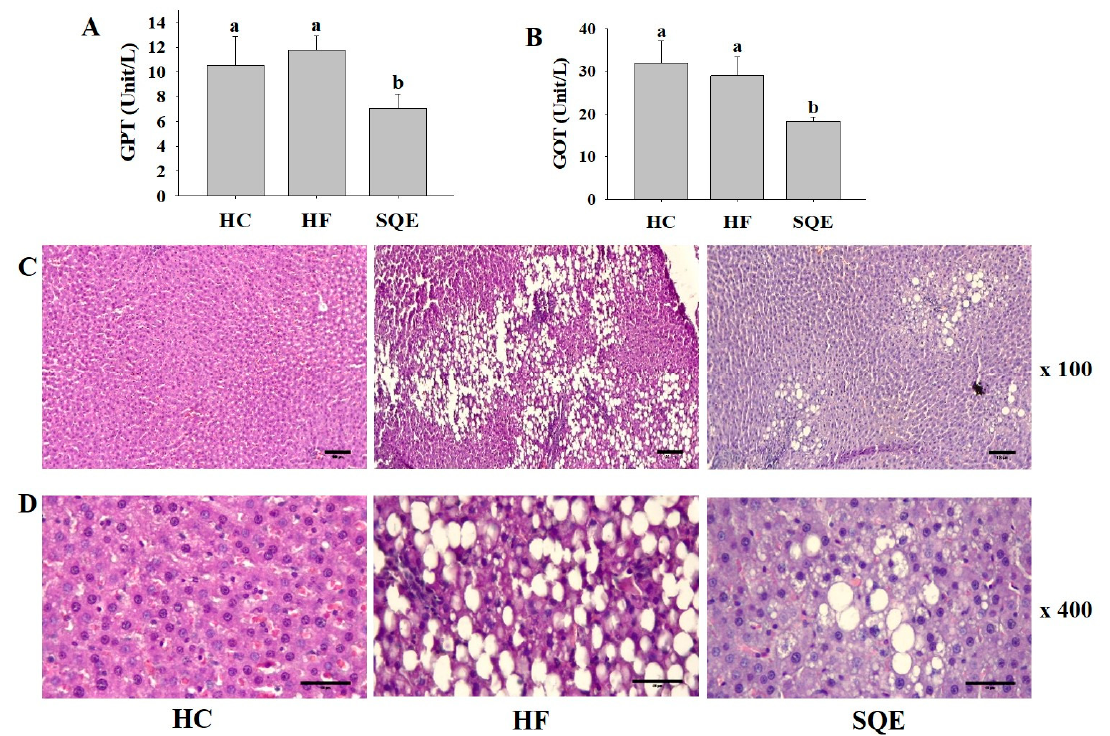
Figure 4. Effect of SQE supplementation on liver function in HF-diet-fed rats: ( A ) Glutamic pyruvic transaminase (GPT) and ( B ) glutamic oxaloacetic transaminase (GOT) levels. Data are given as mean ± SD ( n = 7). Different letters in each assay indicate significant differences among the HC, HF, and SQE groups by Tukey’s multiple range test ( p < 0.05). ( C , D ) Hematoxylin and eosin staining on paraffin sections at ×100 ( C ) and ×400 ( D ) magnification with scale bars of 200 µm and 50 µm. (HC, 46% carbohydrate diet; HF, 60% fructose diet; SQE, 60% fructose diet with SQE (500 mg/kg of BW) in drinking water. BW, body weight; HC, high-carbohydrate-diet-fed rats; HF, high-fructose-diet-fed rats; SQE, the high-fructose-diet-fed rats supplemented with S. quelpaertensis leaf extract.